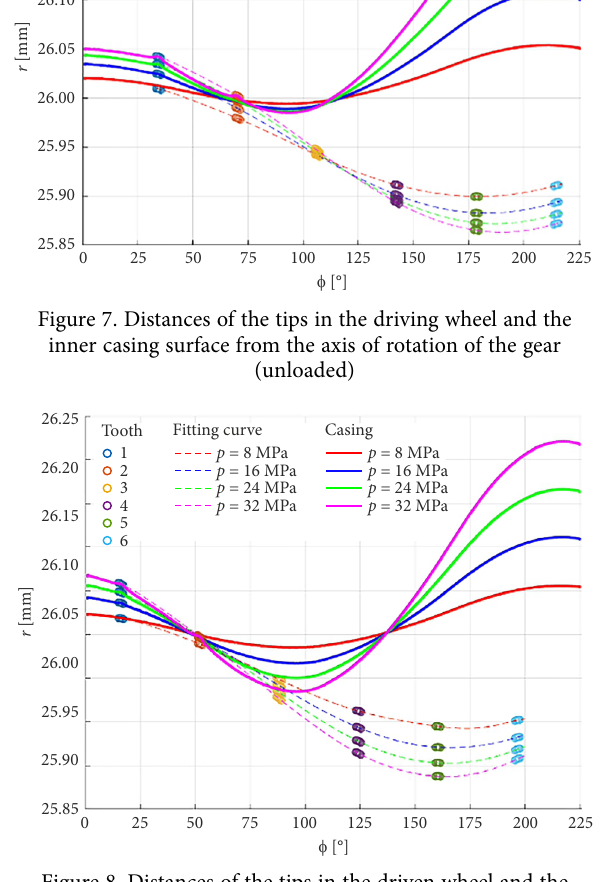
Figure 8. Distances of the tips in the driven wheel and the inner casing surface the axis of rotation of the gear